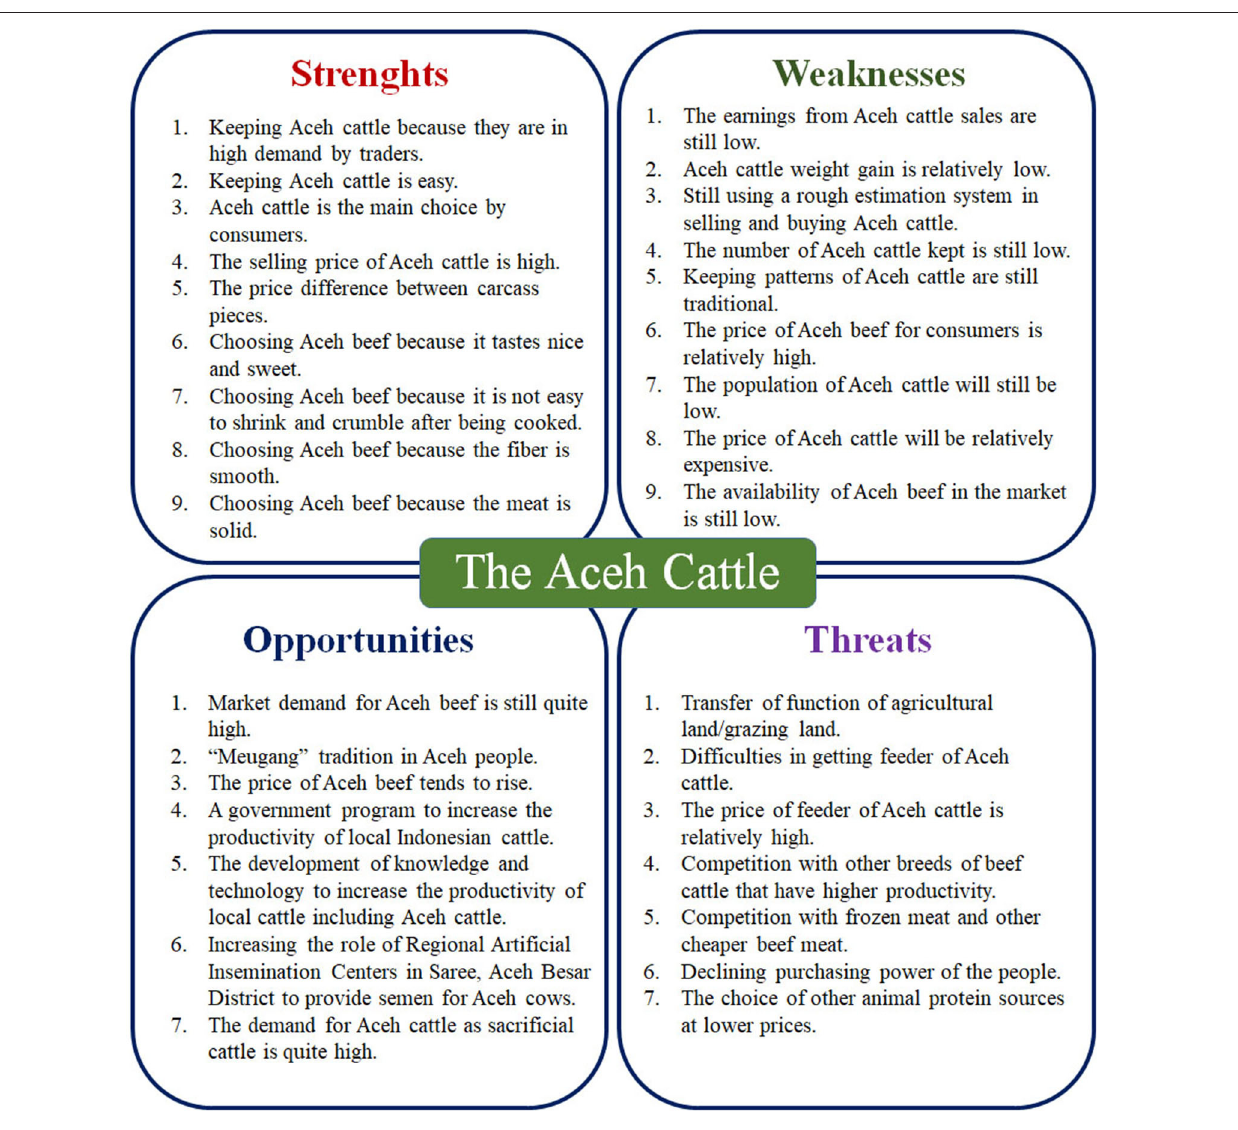
Frontiers in Sustainability |